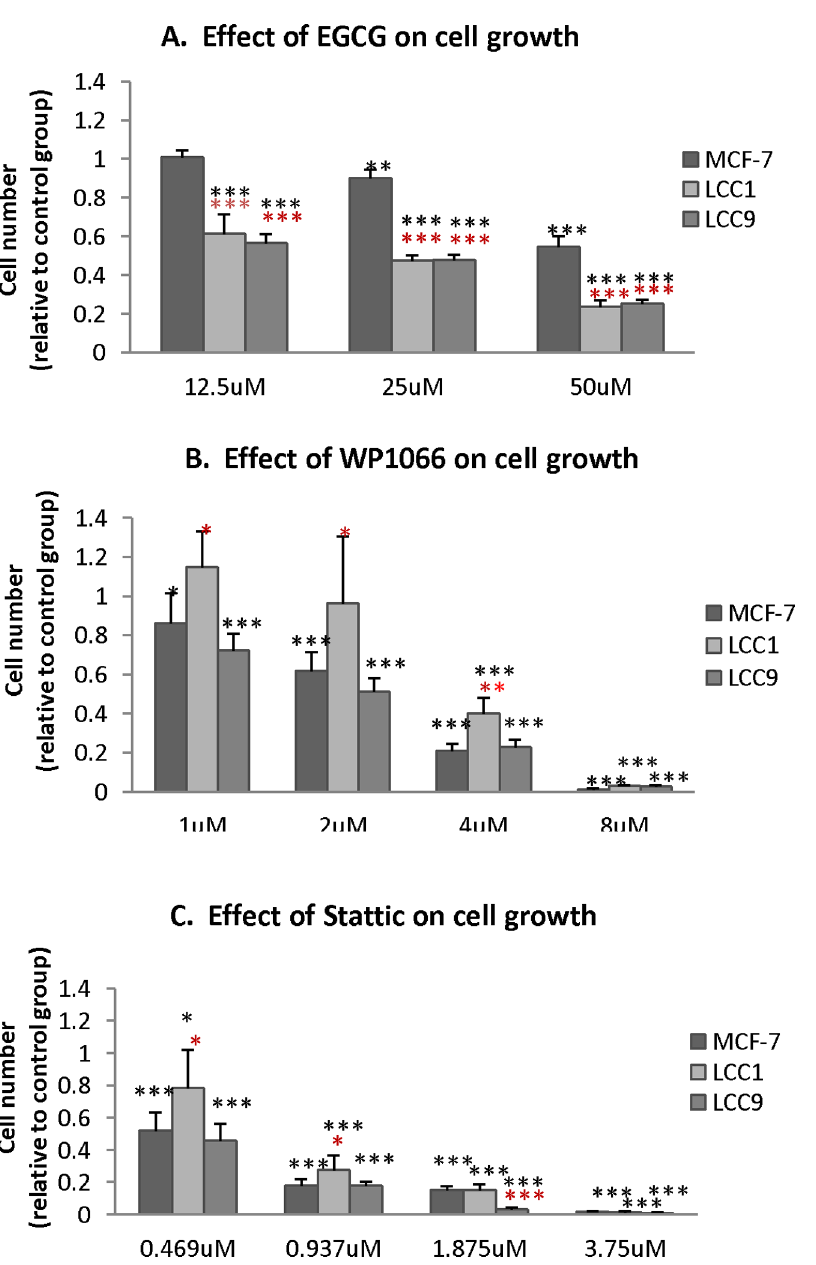
Figure 2. The effect of STAT inhibitors (A. EGCG, B. WP1066 and C. Stattic) on proliferation of Tamoxifen sensitive and resistant (MCF-7, MCF-7/LCC1 (LCC1), and MCF-7/LCC9 (LCC9)) cells. All cells were incubated in double charcoal-stripped medium for another 48 h after seeding and treated with or without inhibitor. O.D values were measured on Day 5. Data were plotted as a mean of O.D values + / 2 SD from 6 replicate samples. Asterisks represent significant changes between treatment and no treatment, while hashes represent differences between resistant cell lines and MCF7. Error bars are standard deviations. Statistical significance noted for treatment groups compared with untreated controls were # / *P , 0.05, ## / **P , 0.01, ### / ***P , 0.001 (ANOVA followed by